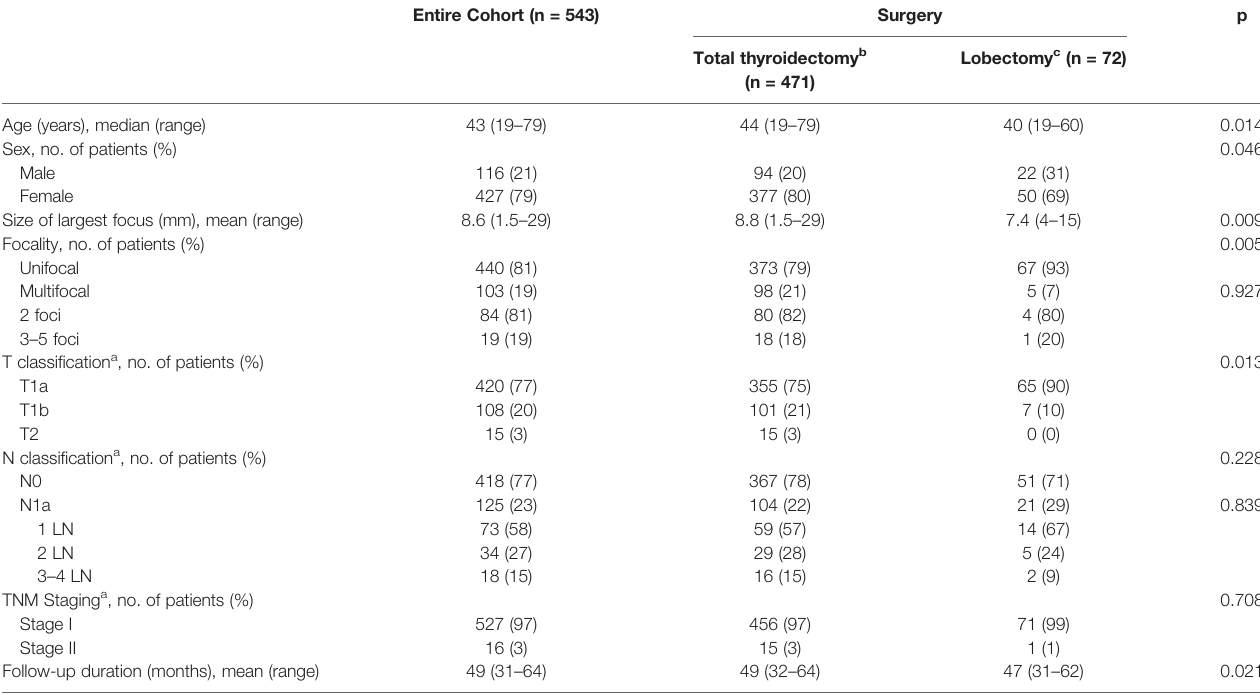
TABLE 2 | Baseline characteristics of the